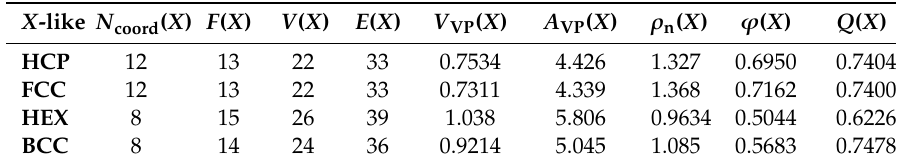
Table 6. Same as in Table 5 but for computer-generated 3-D structures with high crystal similarity (or equivalently low CCE norm), as visualized in Figure 8. Coordination number is deduced from the number of closest neighbors so as to match the one of the reference crystal.